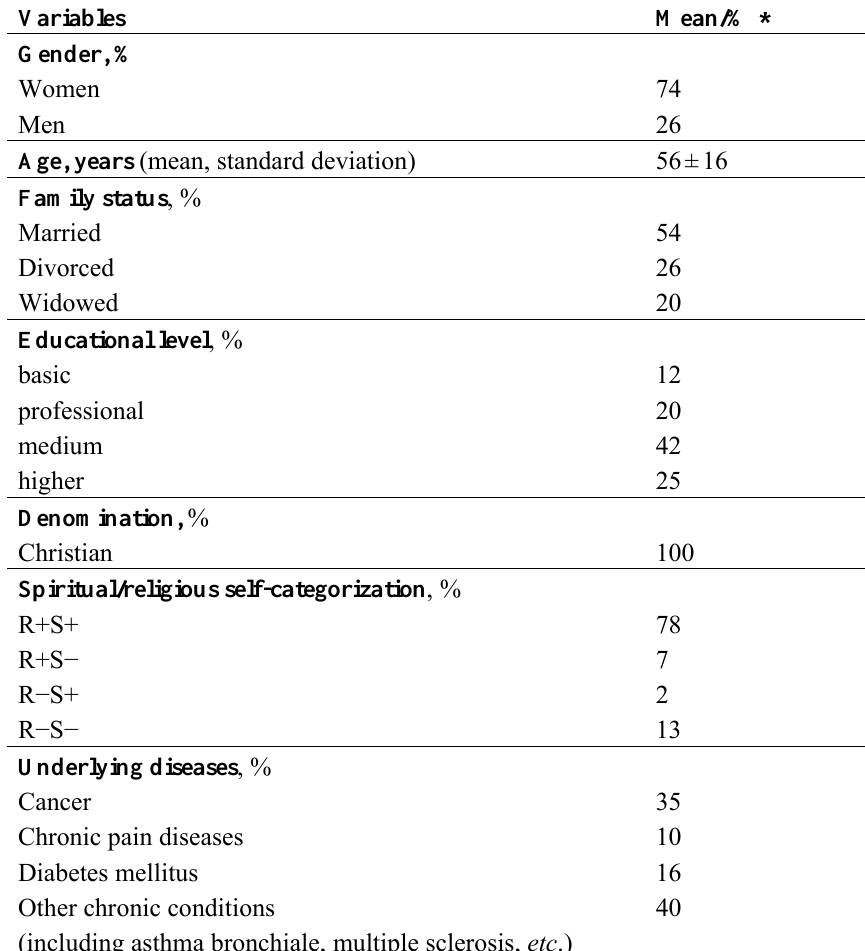
Table 1. Characteristics of 275 patients. R+S+, religious and spiritual; R+S − , religious,